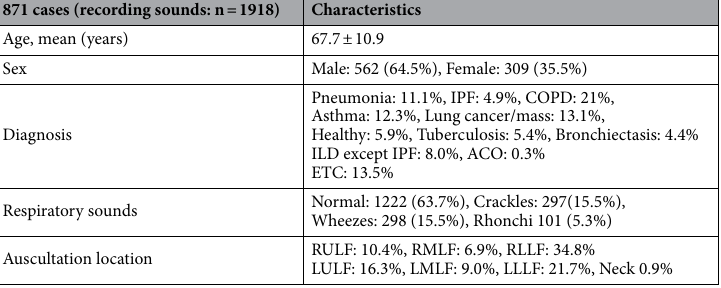
Table 2. Characteristics of respiratory sound database. RULF right upper lobe field, RMLF right middle lobe field, RLLF right lower lobe field, LULF left upper lobe field, LMLF left middle lobe field, LLLF left lower lobe field, COPD chronic obstructive pulmonary disease, ILD interstitial lung disease, IPF idiopathic pulmonary disease, ACO asthma-COPD